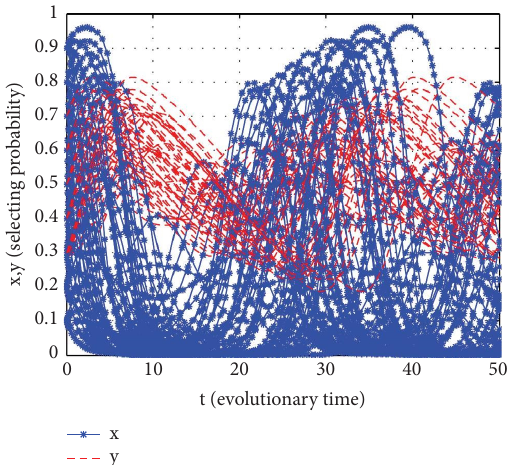
Figure 6: Te evolutionary consequences of Proposition 3.